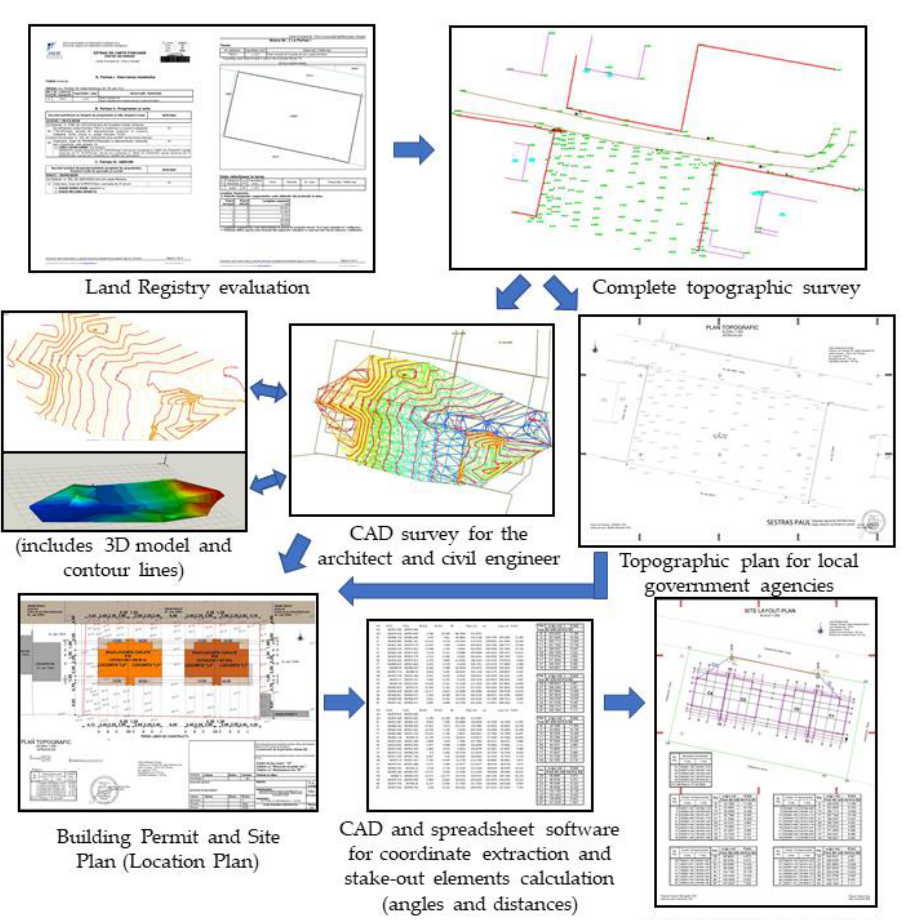
Figure 3. Graphical abstract of the site layout plan process.